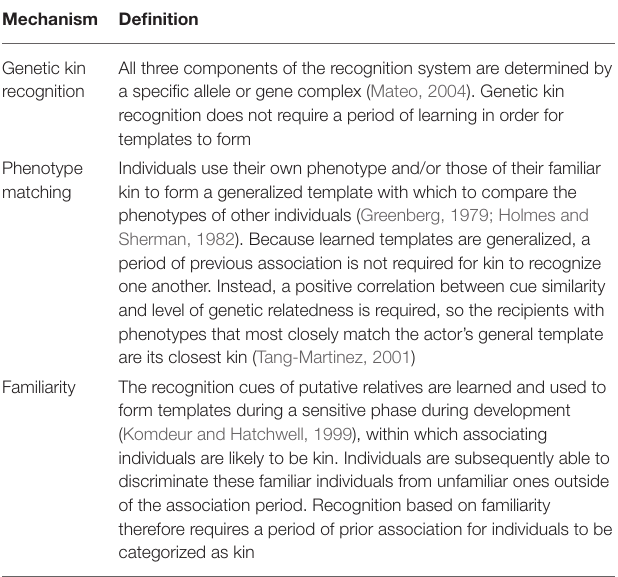
TABLE 2 | Mechanisms of kin